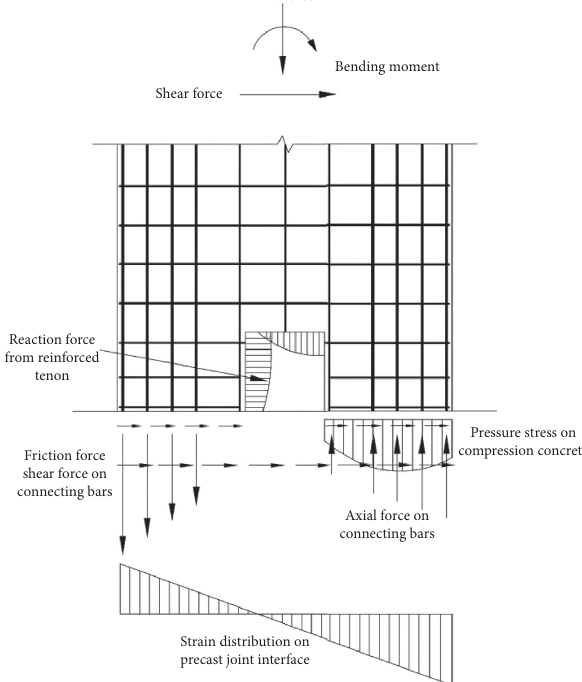
Figure 20: Distributions of internal force and strain at joint